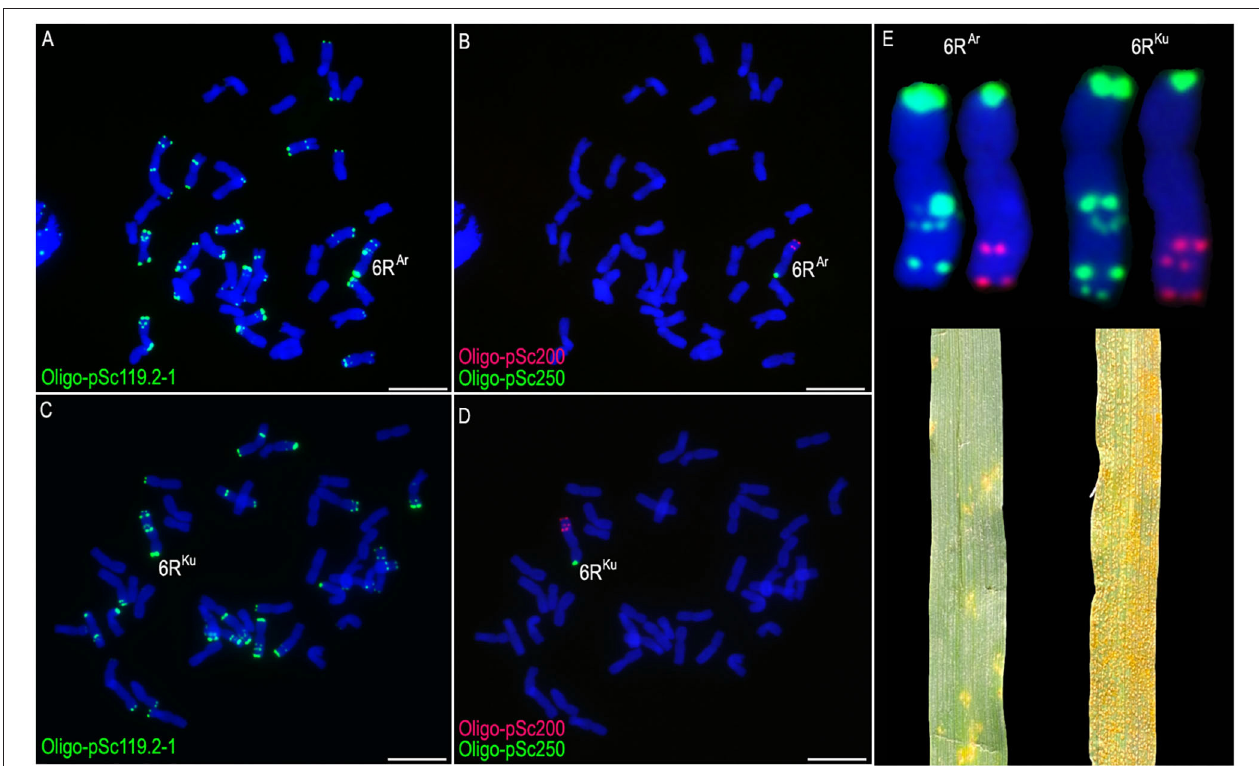
FIGURE 1 | The non-denaturing fluorescence in situ hybridization (ND-FISH) analysis of lines MA6R Ar and MA6R Ku using probes Oligo-pSc119.2-1 (green), Oligo-pSc200 (red), Oligo-pSc250 (green), and their stripe rust resistance test. (A,B) A root-tip metaphase cell of line MA6R Ar . (C,D) A root-tip metaphase cell of line MA6R Ku . (E) Cut-and-paste 6R Ar and 6R Ku chromosomes. 6R Ar was highly resistant to stripe rust and 6R Ku was susceptible. Scale bar: 10 µ m.